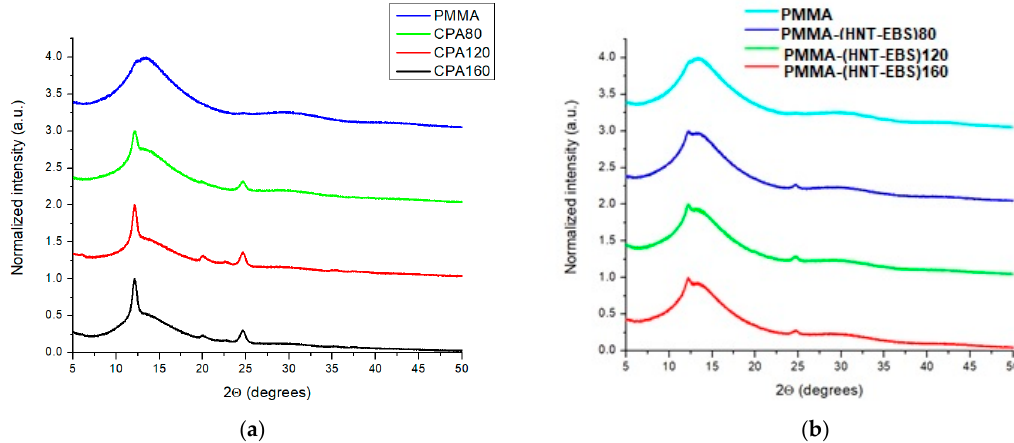
Figure 7. XRD patterns for the masterbatches ( a ) and final PMMA nanocomposites ( b ).